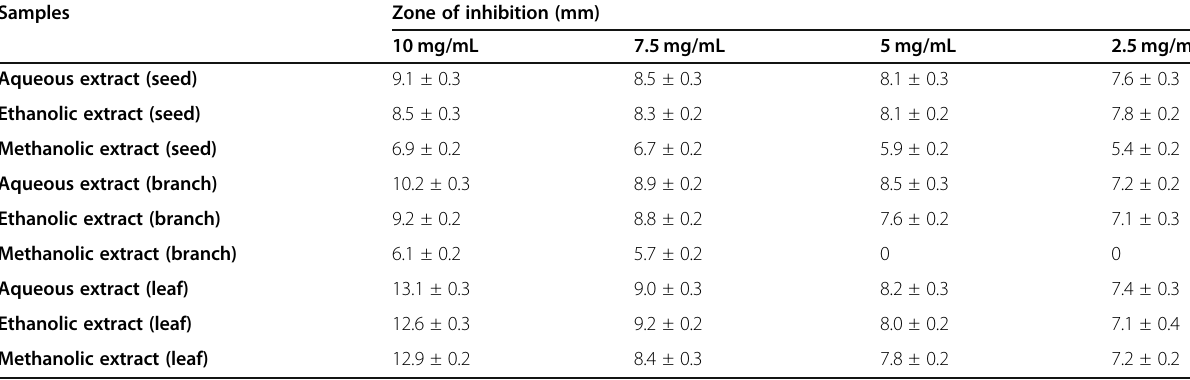
Table 2 Zone of inhibition observed for Gram-negative bacteria Escherichia coli by different concentrations of extracts